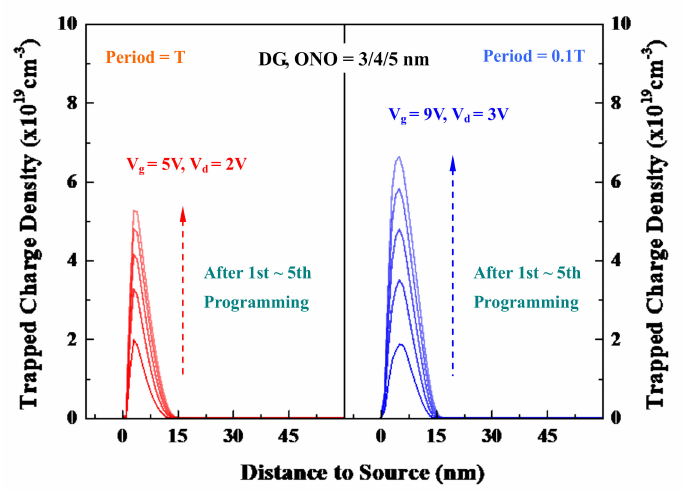
Figure15. Iterativeresultsofspatialdistributionsoftrappedchargesintwooptionsofscaleddouble-gate Schottky barrier cells. One-tenth programming periods were employed in the high-e ffi ciency cells at each programming